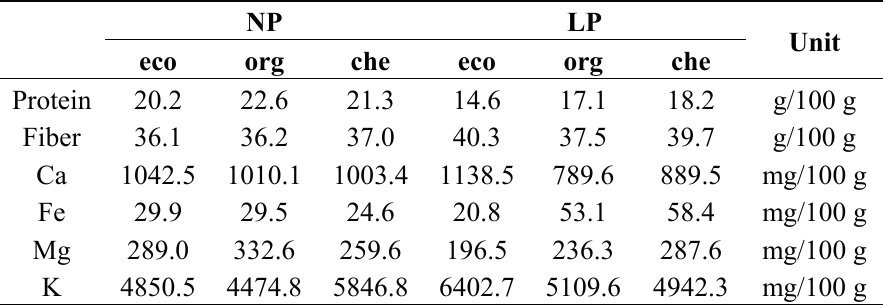
Table 7. Proximate composition and mineral content of